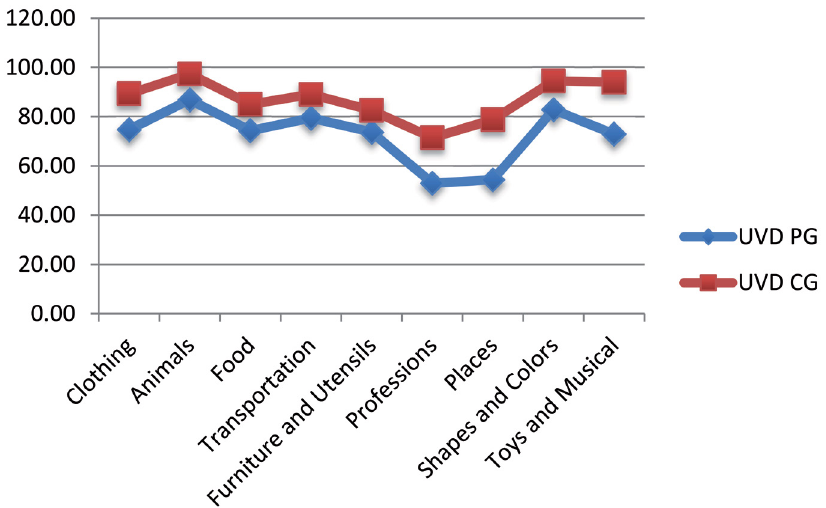
CGPG: Preterm Group; CG: Comparison Group; UVD: correct appointment; RP: replacement processes; ND: no designation. Student’s t-test. Significance level of p<0.05. *: Significant values Figure 2- Performance of the Usual Verbal Designation (UVD) of the ABFW instrument in the PG compared to the